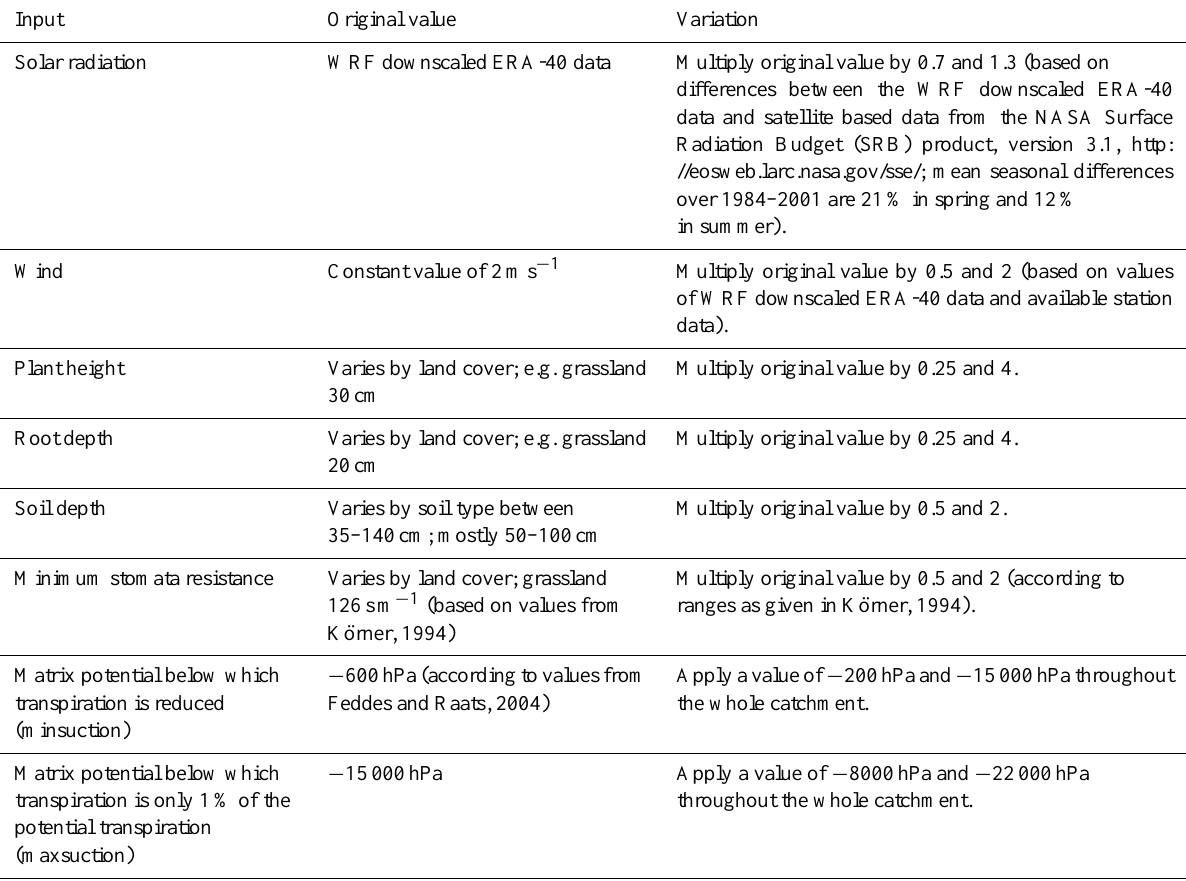
Table 4. Climate, plant and soil inputs selected for the sensitivity